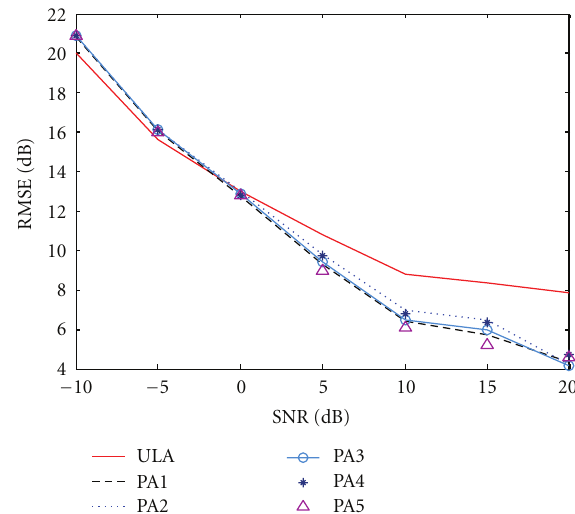
Figure 12: Total RMSE of the MUSIC algorithm for di ff erent combined array configurations in scenario 2.